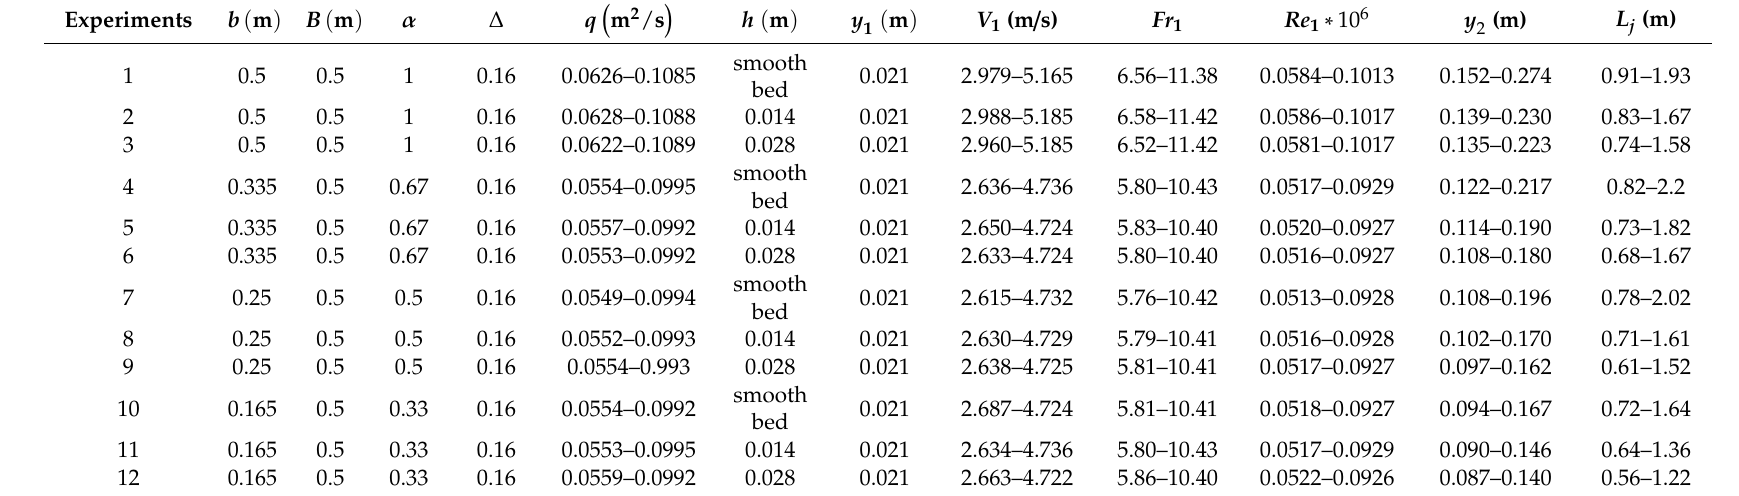
Table 1. Main parameters of the present experimental